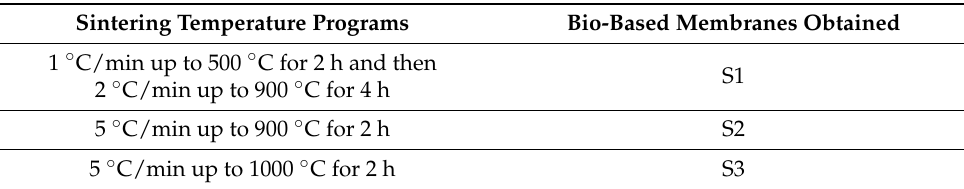
Table 1. Bio-based ceramic membranes